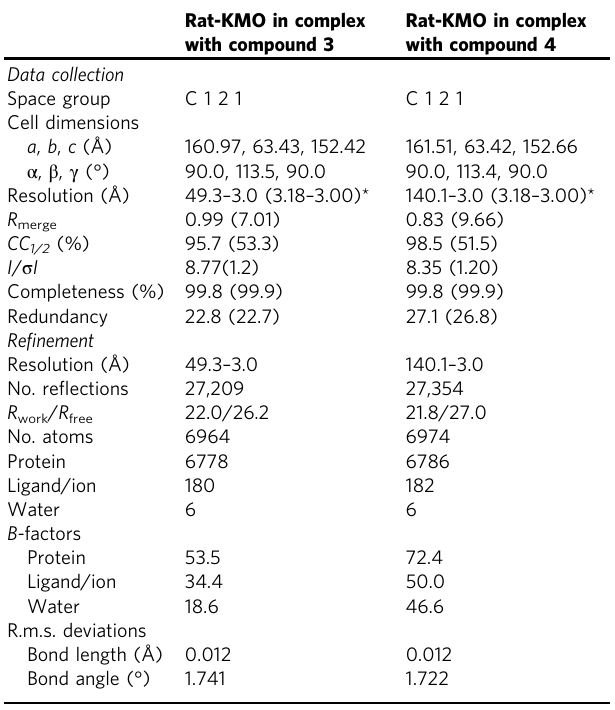
Table 2 Data collection and re fi nement statistics (molecular